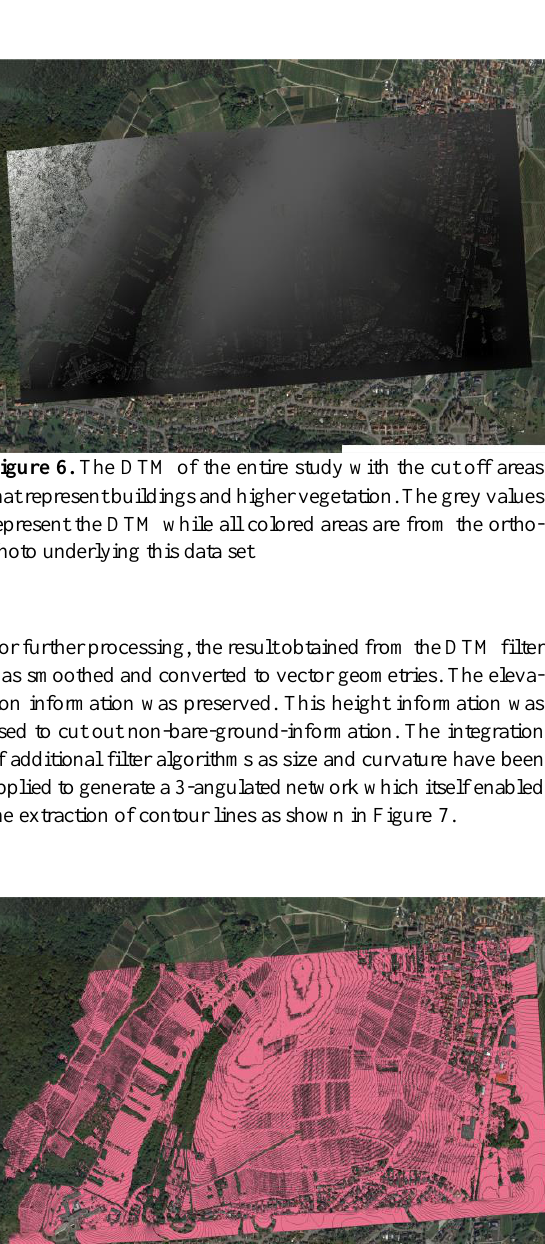
Figure 7. The final received vector based DTM with objects shown that are placed on top of the surface in colors from the orthophoto or the colored point